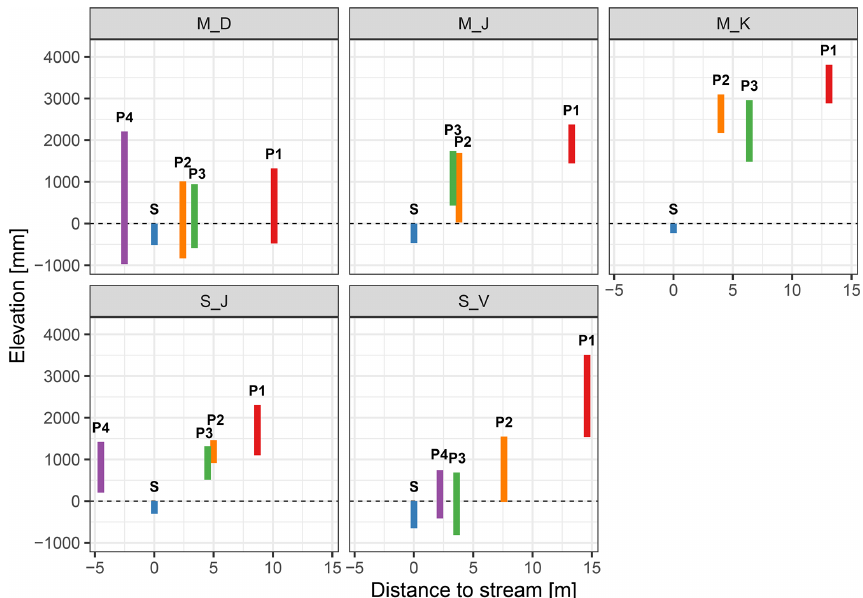
Figure 3. Elevations of ground level (upper end of the bar) and sensor level (lower end) relative to the streambed. Stream sensors were installed slightly below the streambed (negative lower end). Distance to the stream is shown on the x axis. Colour coding is the same as in Fig.